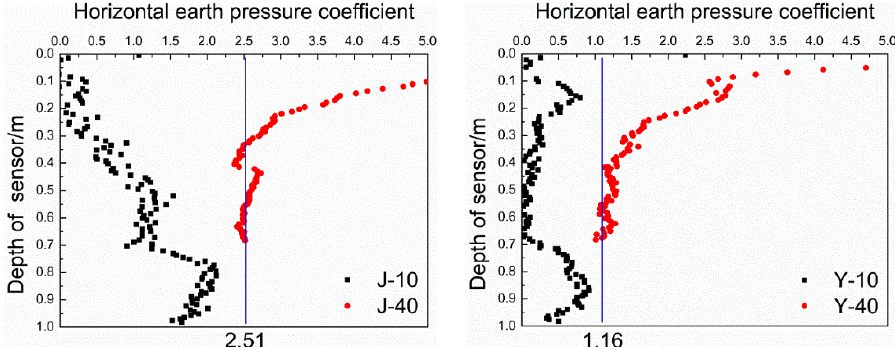
Figure 12. HB30 model. Note: J-10 and J-40 denote the soil-pressure sensor with different heights of 0.8 m from the side wall, and Y-10 and Y-40 denote the sensor on the other side of the model.